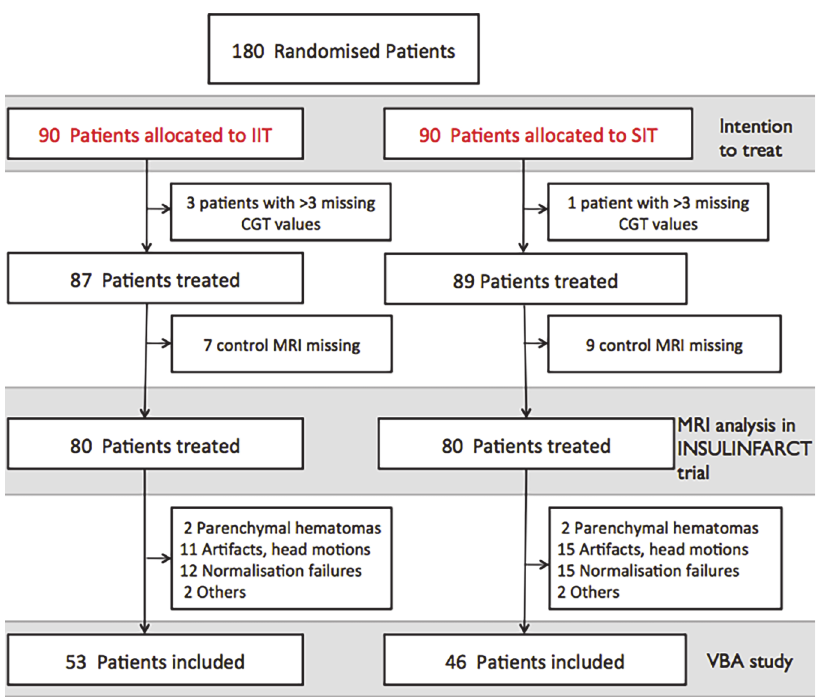
Fig 1. Flow chart of the study. CGT means Capillary glucose test. As pre-specified in the main protocol, patients for whom ore than 3 CGTs were missing during the treatment had to be excluded. VBA means voxel- based analysis and the VBA study refers to the study presented in this